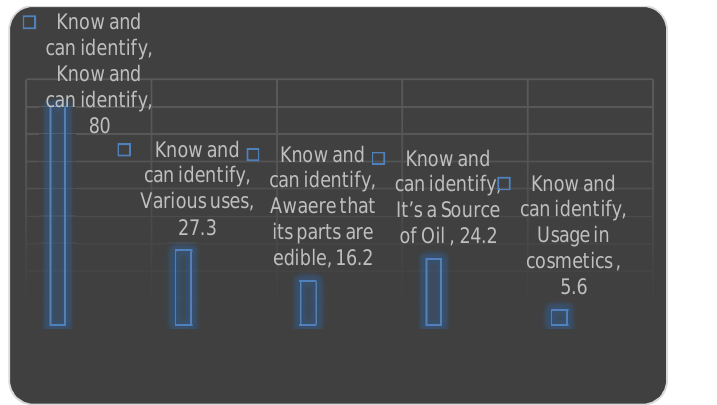
Figure 10: Knowledge of baobab tree usage Table 2: Level of Awareness of the Baobab Plant among Respondents Various Aspects of the Baobab Plant